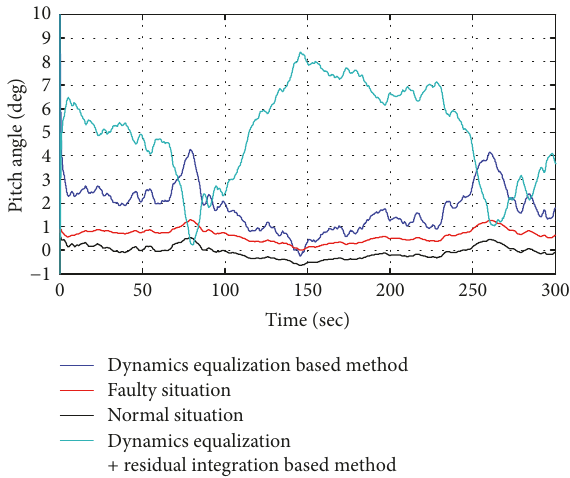
Figure 11: The pitch angles (control effort) in the normal, faulty, and fault tolerant situation.